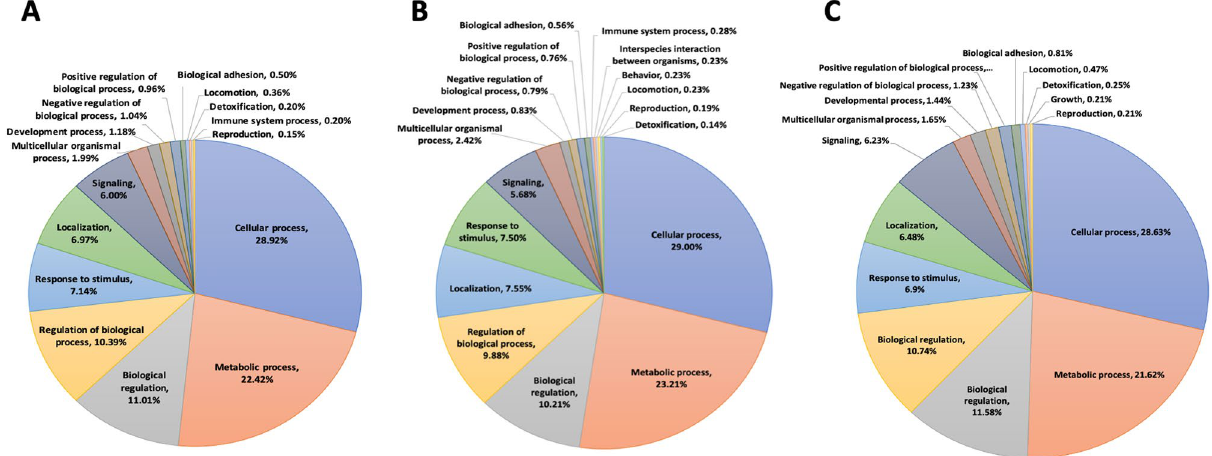
Figure 4. Distribution of transcripts annotated at the gene ontology level 2 and their putative biological functions for ( A ) all transcripts differentially abundant between Plasmodium falciparum sporozoite infected treatment Anopheles gambiae s.s. and naïve controls, ( B ) only transcripts differentially abundant in sporozoite infected treatments, and ( C ) only transcripts differentially abundant in naïve